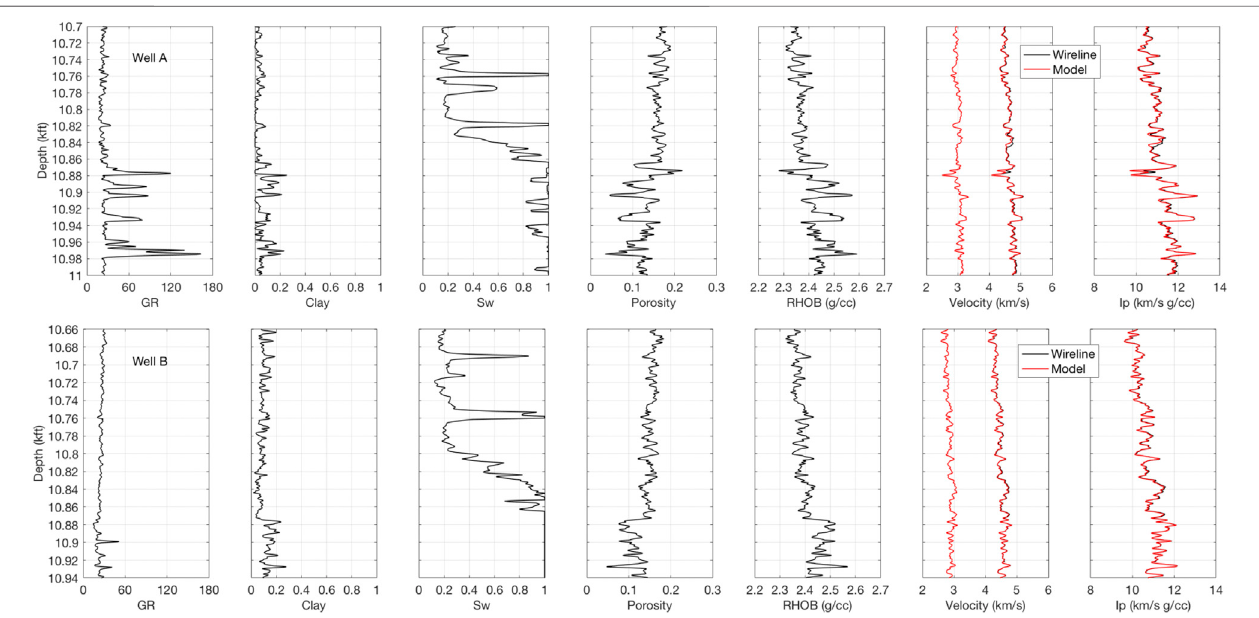
FIGURE8| Wireline dataforWellA (top) and WellB (bottom) .From lefttoright: GR;claycontent;watersaturation; thetotalporosity;bulk density; V p and V s ;and the P-wave impedance. Black curves are for measured properties, while red curves are for model-predicted.